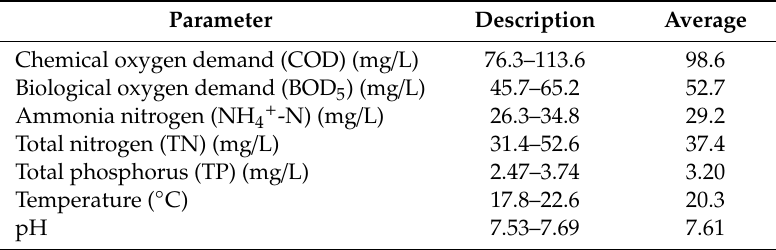
Table 1. Characteristics of the raw wastewater.